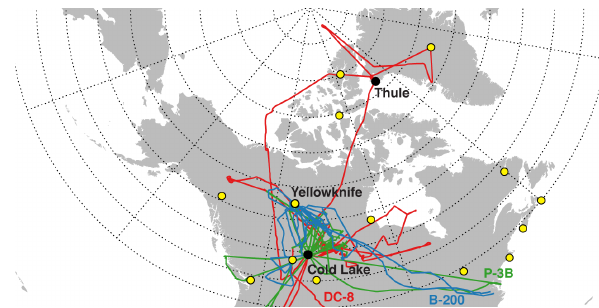
Figure 1b. Flight tracks for the ARCTAS-B summer deployment (Table 5a-c). Yellow circles are ozonesonde launch sites (Table 3d) Fig. 1b. Flight tracks for the ARCTAS-B summer deployment (Ta- ble 5a–c). Yellow circles are ozonesonde launch sites (Table